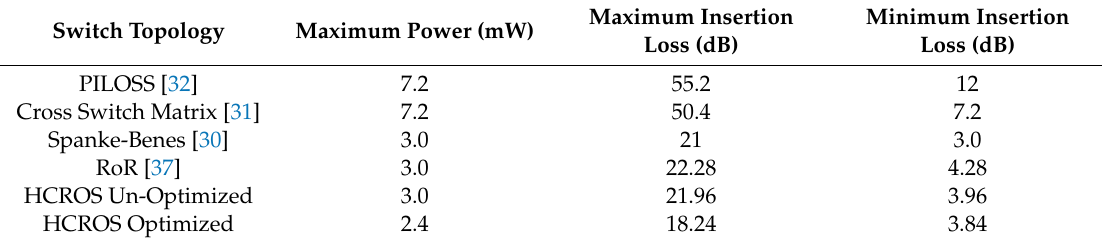
Table 10. Performance analysis of 6-port optical switches / routers.